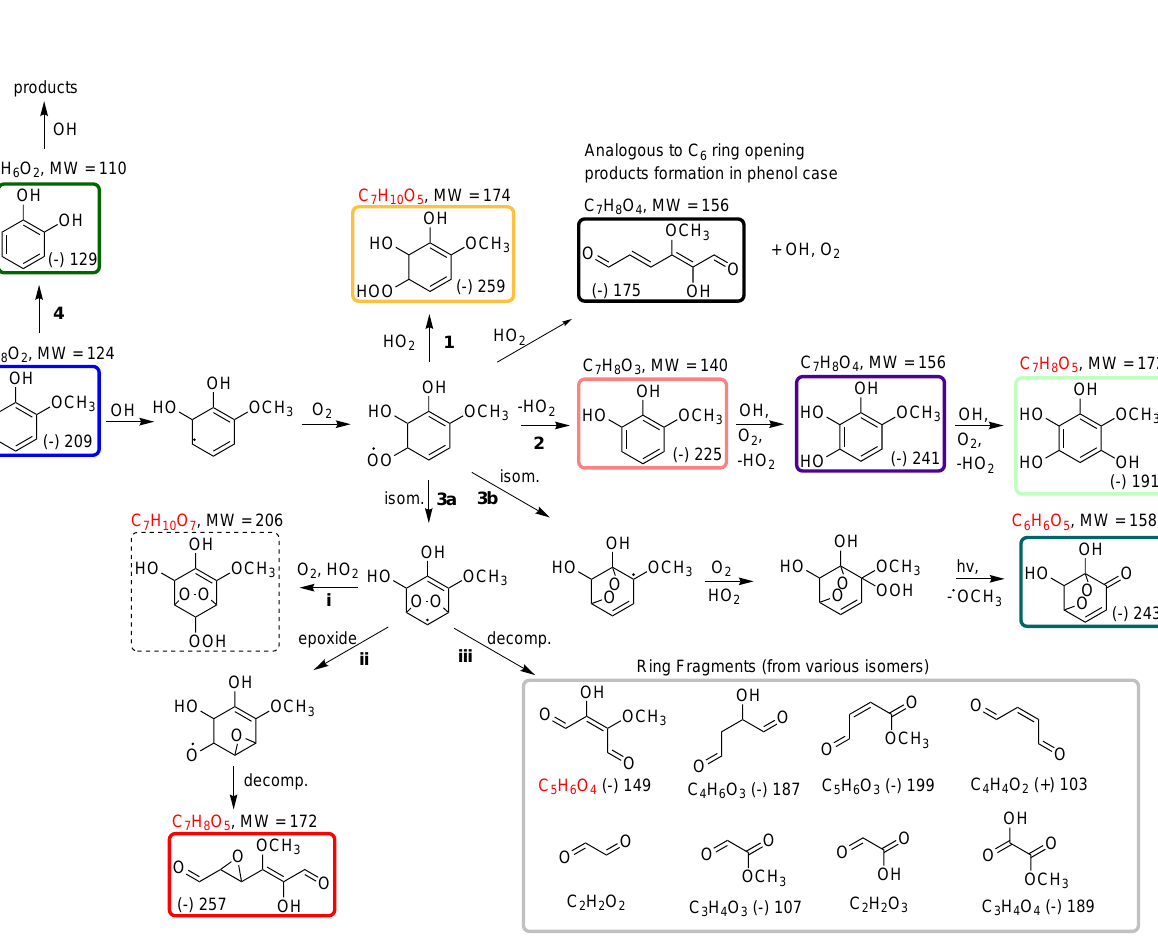
Fig. 4. Proposed mechanism for guaiacol low-NO x oxidation. Boxed structures indicate that the expected m/z from the chemical ionization reactions in the CIMS for that compound was detected. Chemical formulae in red correspond with those proposed for the filter accurate mass aerosol